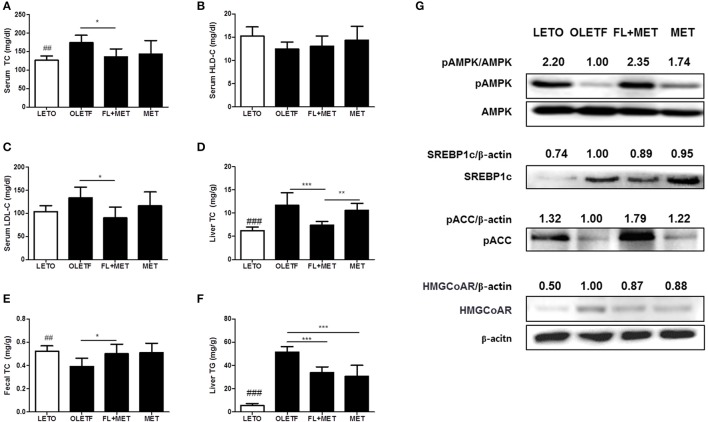
Effect of FL on lipid profiles and liver protein expression levels in OLETF rats. The concentration of total cholesterol (A), HDL cholesterol (B), and LDL cholesterol (C) in the serum of OLETF rats were measured. The content of and hepatic (D) and fecal total cholesterol (E) and hepatic TG (F) in OLETF rats were determined. The protein expression of SREBP-1c, HMGCoA reductase and phosphorylation levels of AMPK and ACC in the liver of OLETF rats were estimated by Western blotting. Representative blots from at least three individual experiments for each protein are shown (G). The density of the bands in each blot was quantified by densitometric analysis and expressed as pAMPK/AMPK, SREBP-1c/β-actin, pACC/β-actin, and HMGCoA reductase/β-actin. Data are expressed as mean ± SD (n = 7). ##P < 0.01; ###P < 0.001 vs. LETO group; *P < 0.05; **P < 0.01; ***P < 0.001 vs. OLETF group.